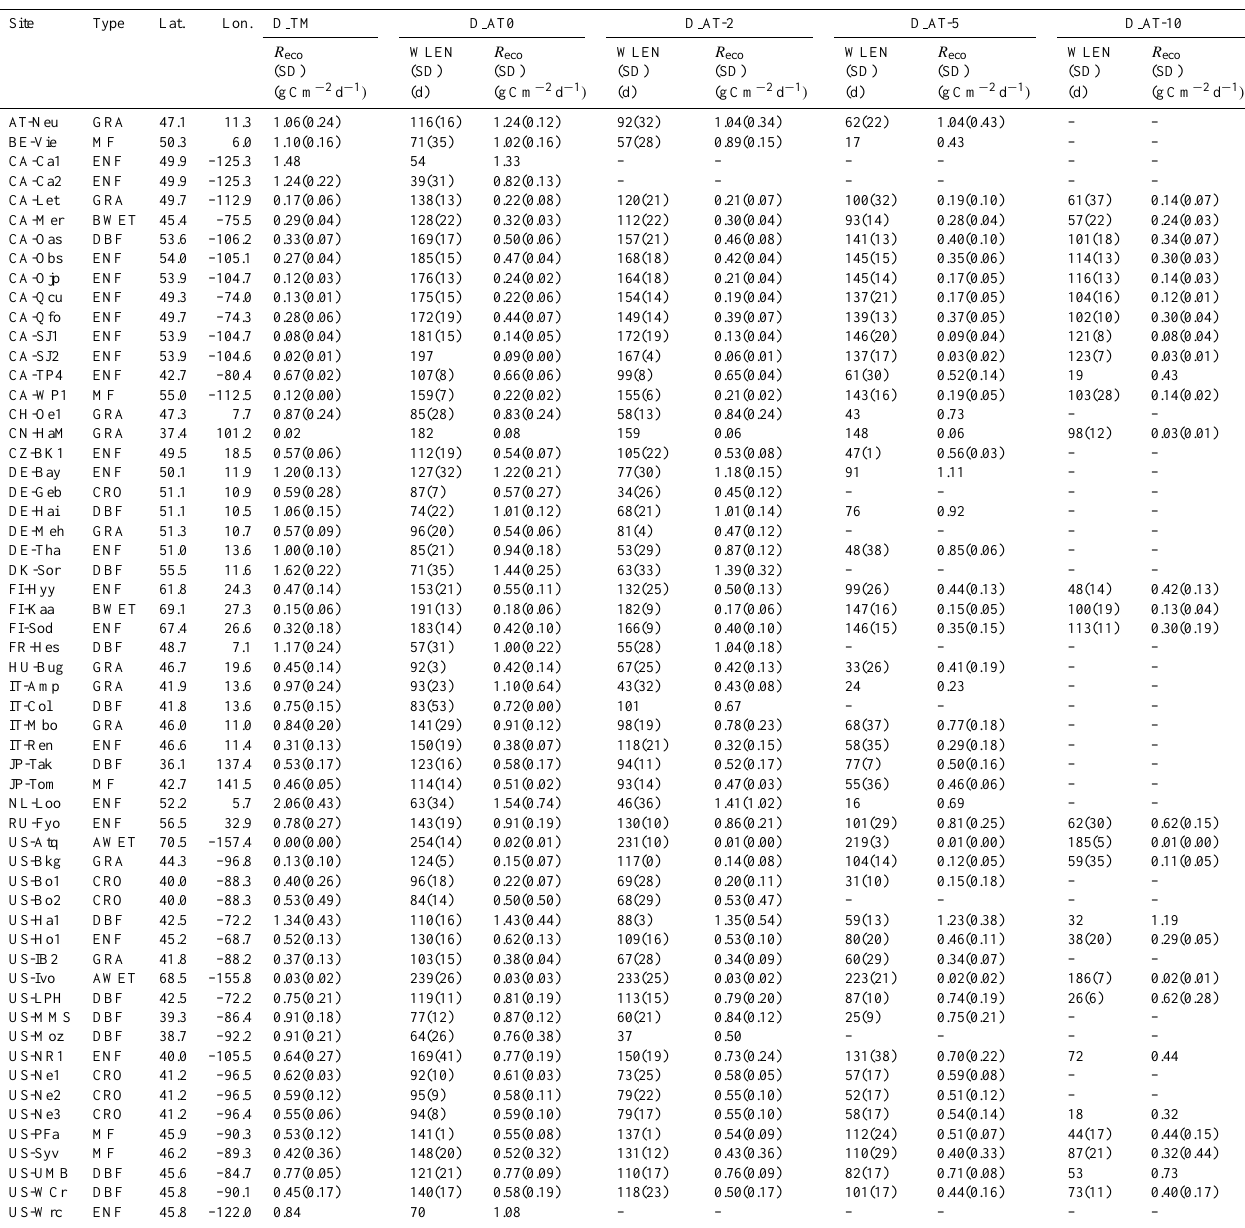
Table A1. Winter R eco rates (gCm − 2 d − 1 ) comparison among different winter